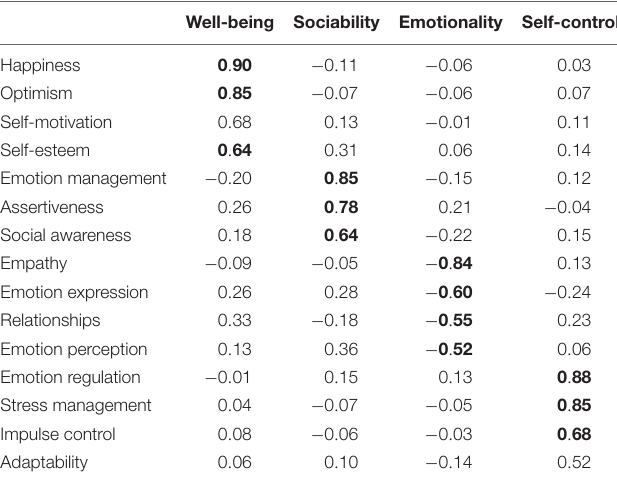
TABLE 2 | Factor pattern matrix for the TEIQue facets.